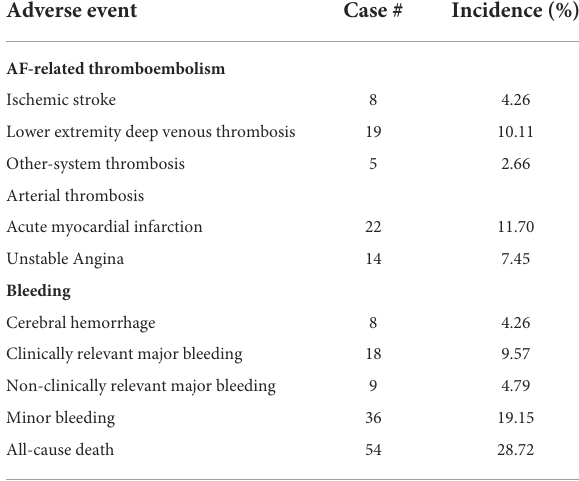
TABLE 2 Adverse clinical events in 188 elderly patients with AF at high risk of thromboembolism and bleeding during 2-year follow-up. Adverse